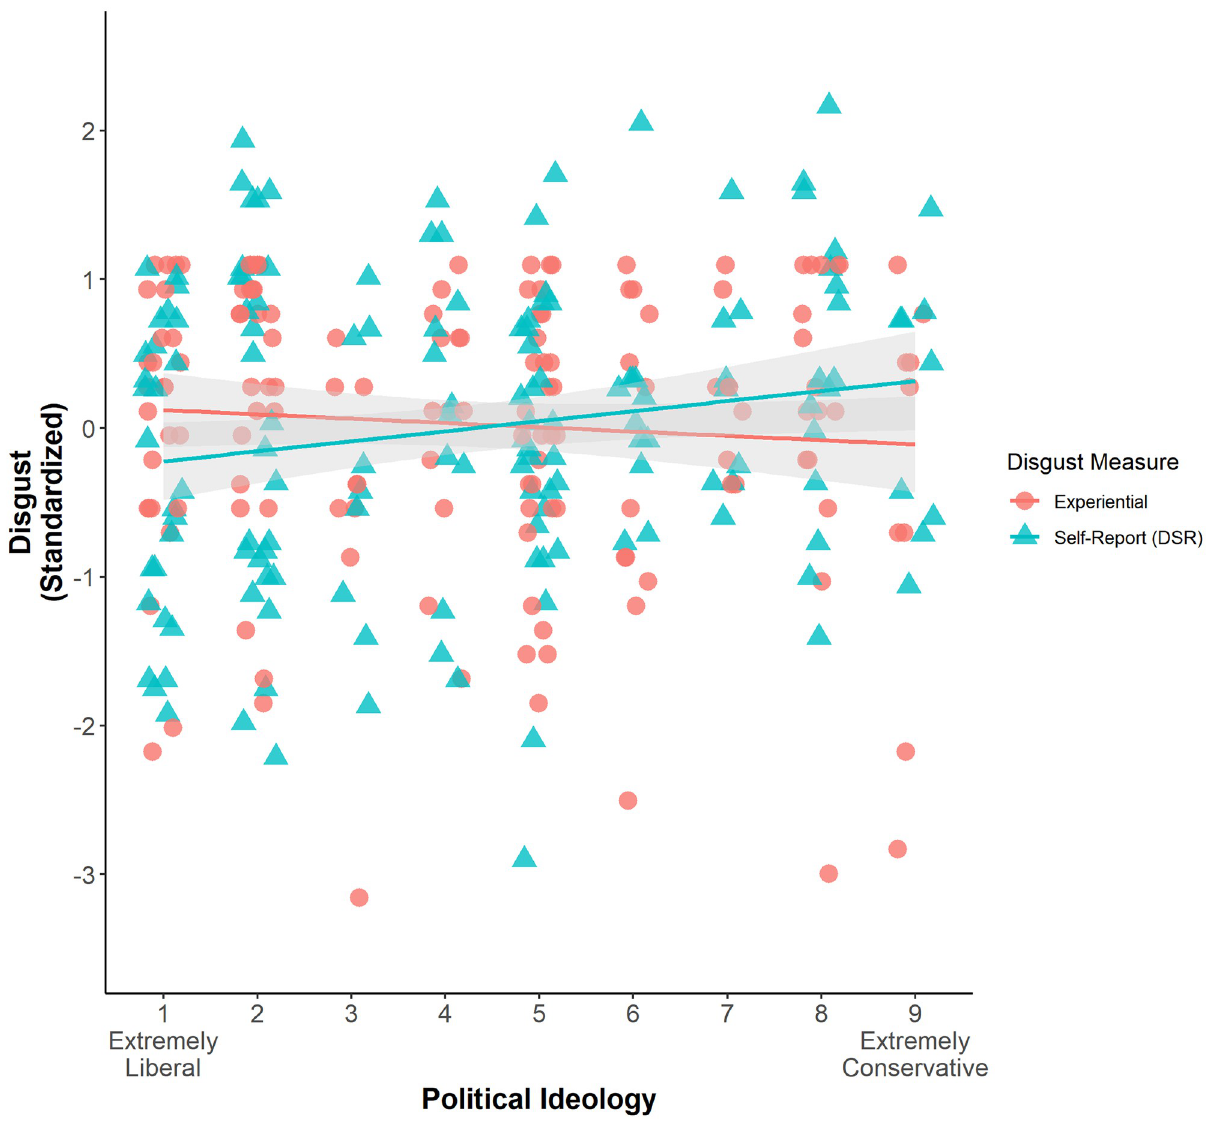
Fig 2. Scatterplot illustrating the relations between political ideology and the two disgust sensitivity measures from Study 4. Experiential disgust sensitivity scores are plotted as red circles, and self-reported disgust sensitivity scores are plotted as green triangles. Shaded areas represent the 95% confidence intervals of the regression